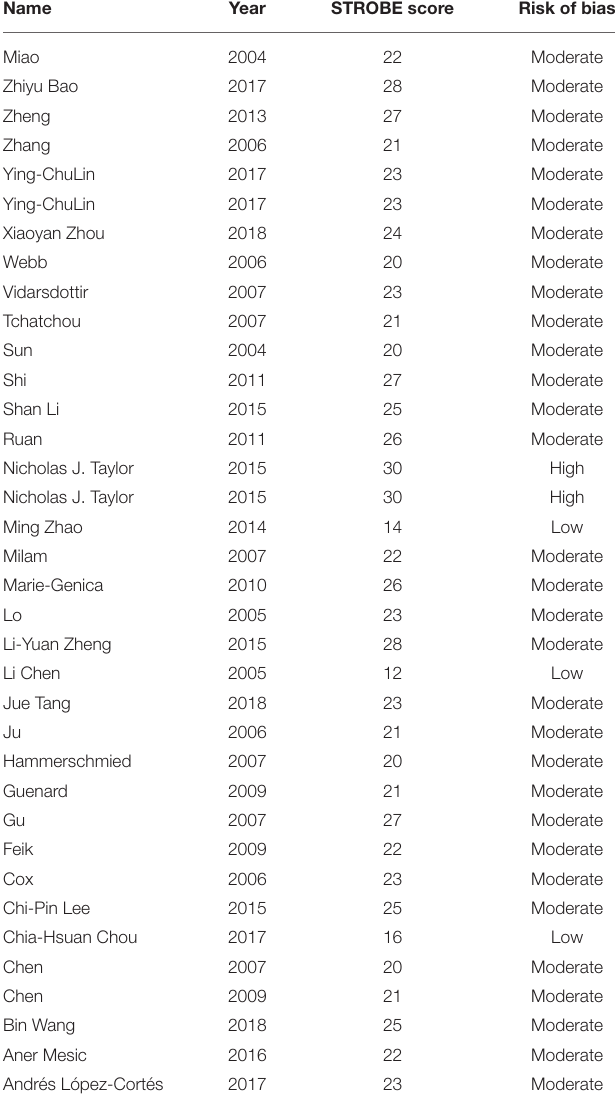
TABLE 1 | The risk of bias